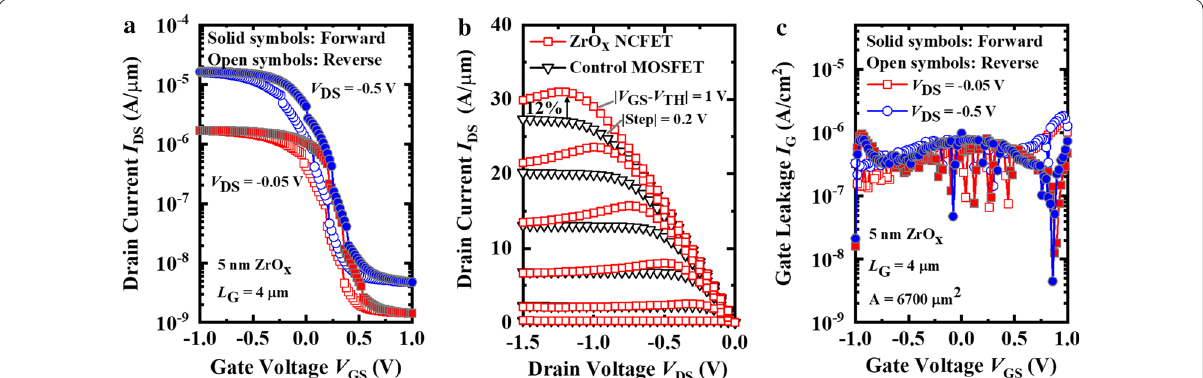
Fig. 4 a Measured I DS – V GS curves of the 5 nm ZrO x NCFET when V DS and the control MOSFET demonstraing the obvious NDR phenomenon. c Measured I G – V GS curves of the 5 nm ZrO x NCFET when V DS V DS 0.05 V = −